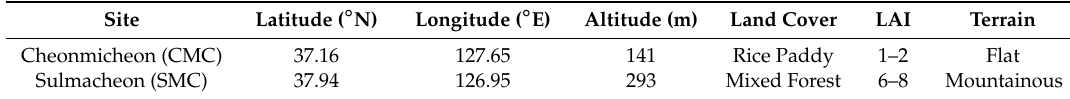
Table 1. Characteristics of the selected sites in study area.